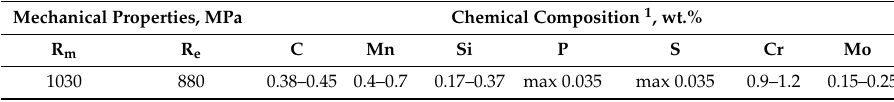
Table 1. Nominal properties of 42CrMo4